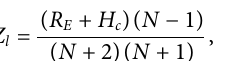
Frontiers in Earth Science |